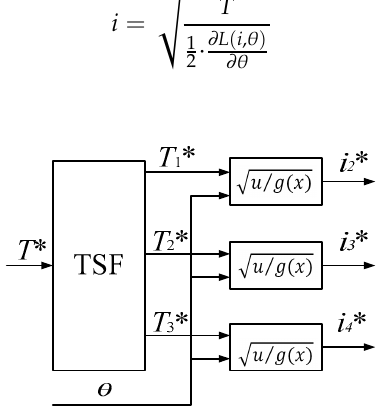
Figure 11. Torque sharing function block for the rotary part.